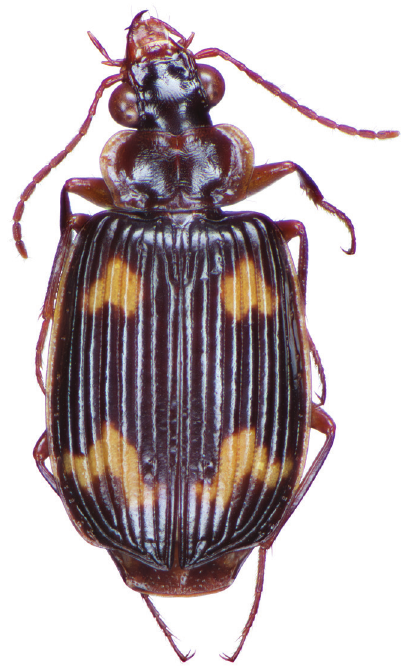
Figure 47. Dorsal habitus and color pattern of C. ( Coptoderina ) marginata (Dupuis). (OBL 9.24